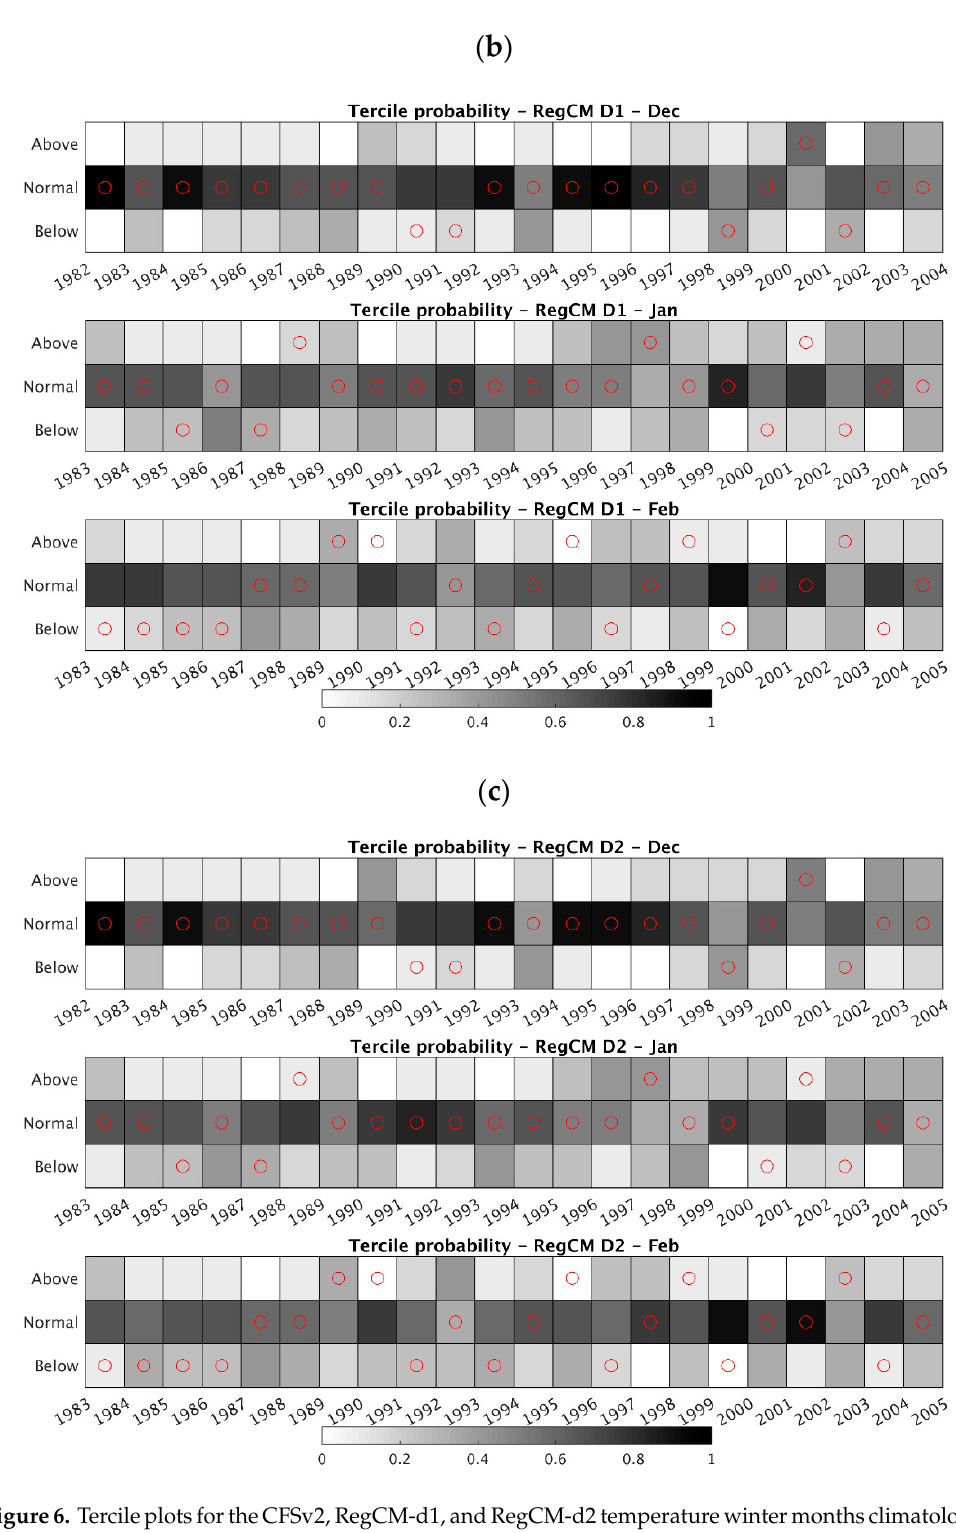
Figure 6. Tercile plots for the CFSv2, RegCM-d1, and RegCM-d2 temperature winter months climatology (sub panels ( a ), ( b ), and ( c ) respectively). Shading of each square represents the portion of ensemble members predicting monthly values: below ( ≤ 1st tercile), normal ( ≥ 1st and ≤ 3rd tercile), and above ( ≥ 3rd tercile) the climatological mean of the relative ensemble member. Red dots show the corresponding reanalysis tercile for each year of the climatological period.